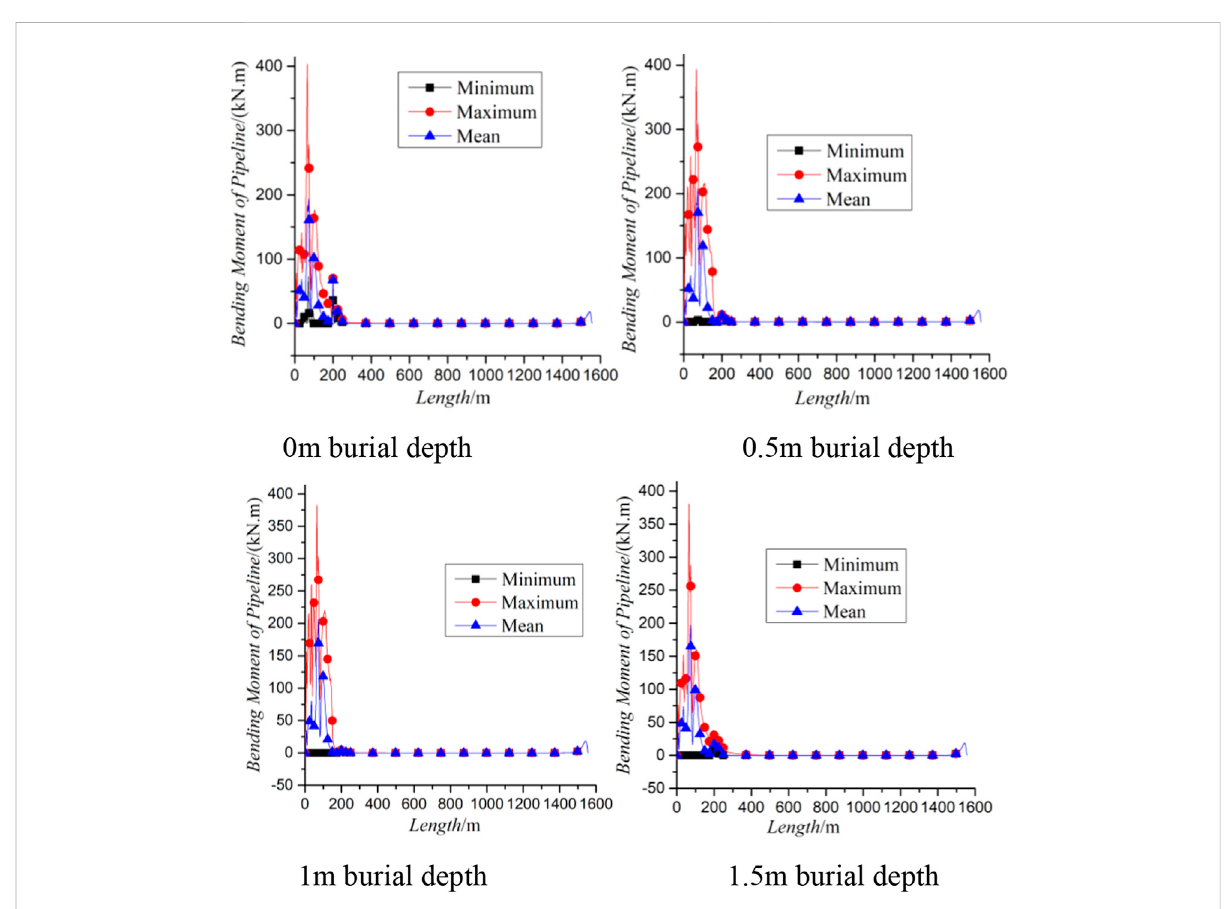
FIGURE 10 Bending moment of the pipeline in the length direction with different burial